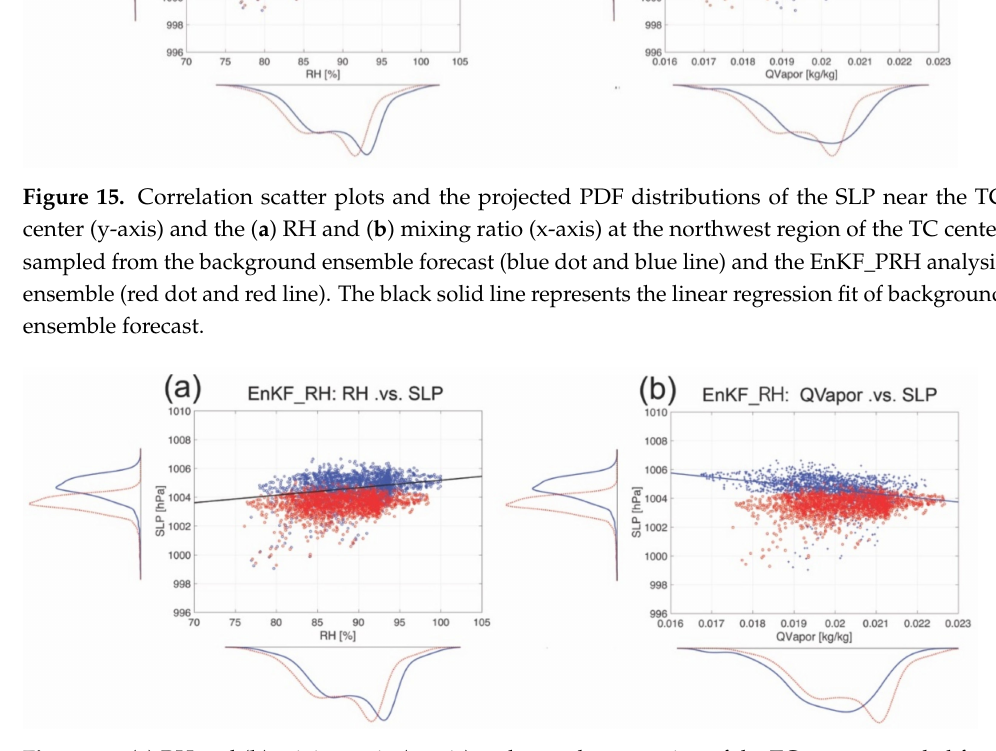
Figure 16. ( a ) RH and ( b ) mixing ratio (x-axis) at the northwest region of the TC center sampled from the background ensemble forecast (blue dot and blue line) and the EnKF_PRH analysis ensemble (red dot and red line).